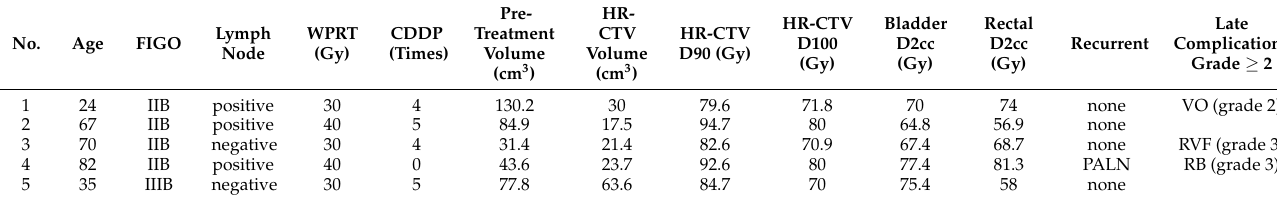
Table 4. Clinical variables of 18